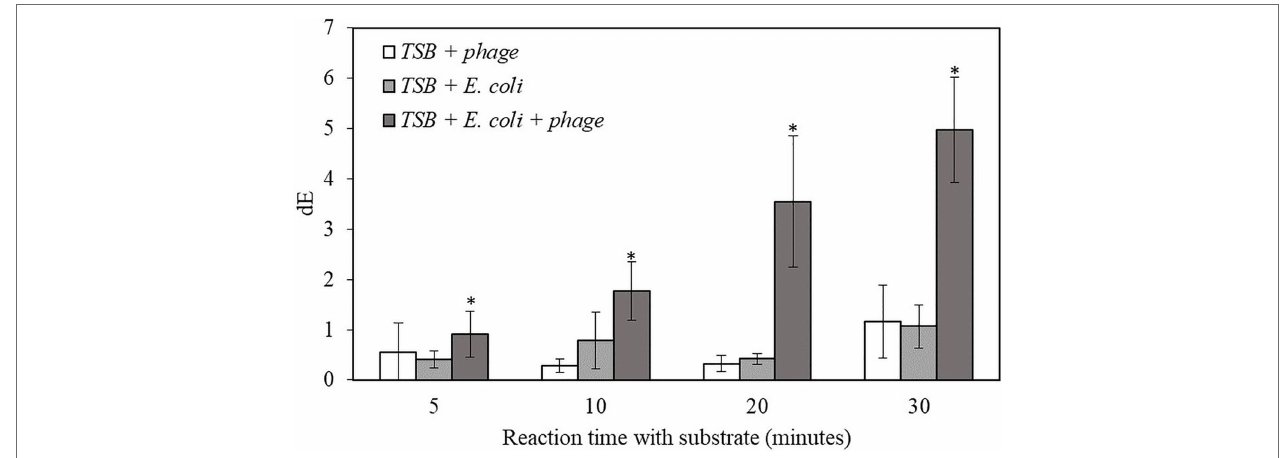
FIGURE 2 | The dE value of the filter with bacteriophage T7-ALP in TSB, 5-h enriched 10 CFU/mL E. coli BL21 and 30 min with and without infection with bacteriophage T7-ALP in TSB after enzymatic reaction with NBT/BCIP for 5, 10, 20, and 30 min. Treatments with “ * ” are significantly different ( p < 0.05). Error bars indicate ±standard deviation of